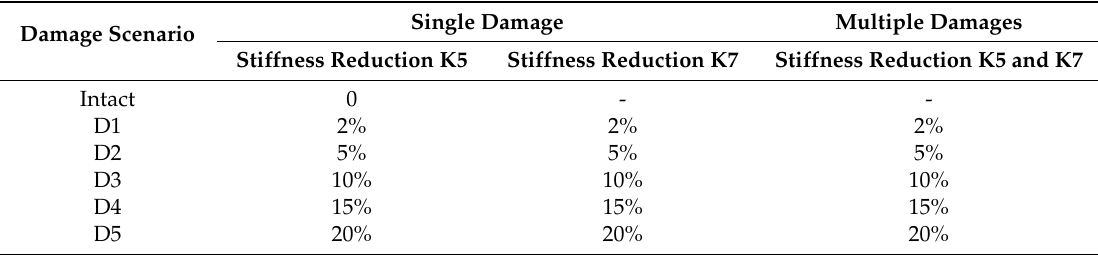
Table 1. Damage scenarios for the noisy free